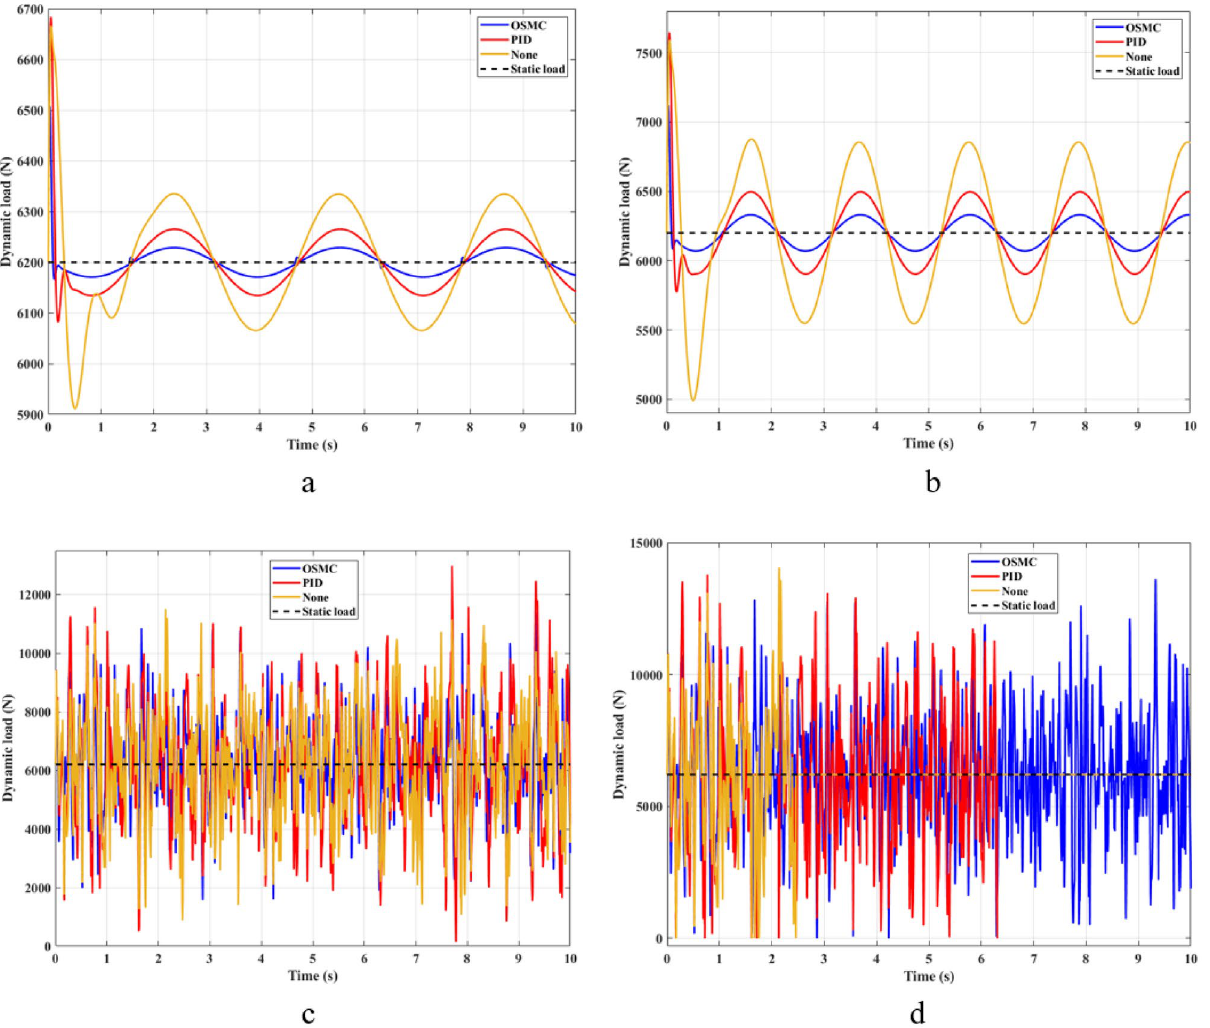
Figure 6. Dynamic load (( a ) Case 1; ( b ) Case 2; ( c ) Case 3; ( d ) Case